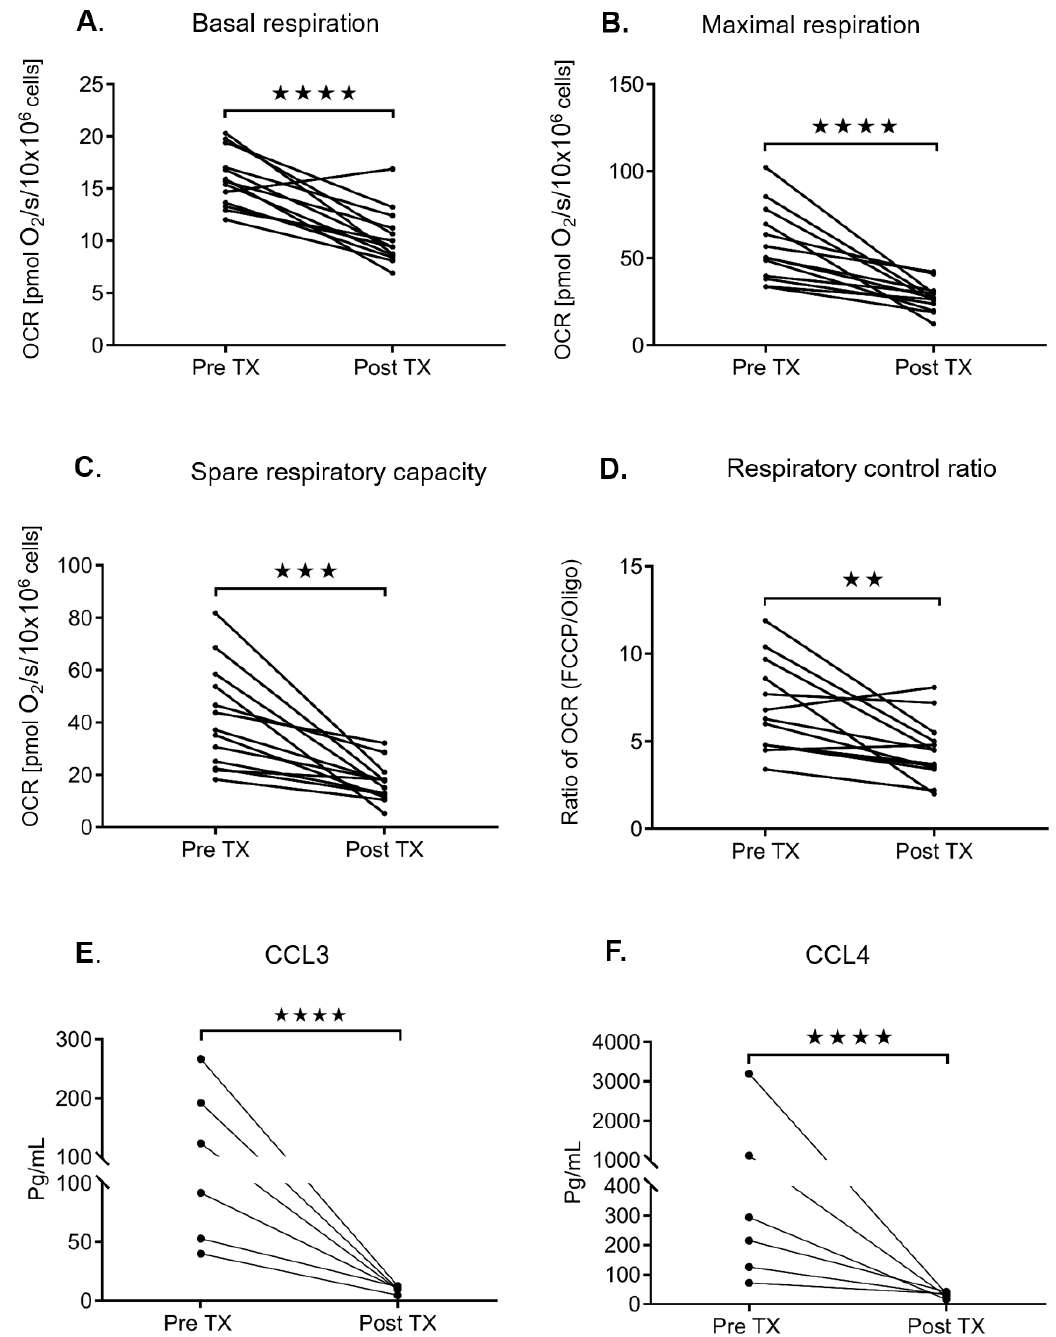
Figure 5. Comparison of mitochondrial bioenergetic profiles in pre- and post-ibrutinib treated CLL patients. The effect of ibrutinib treatment on basal respiration ( A ), maximal respiration ( B ), the spare respiratory capacity ( C ), the respiratory control ratio ( D ), CCL3 levels ( E ), and CCL4 levels ( F ) in pre- and post- treated ibrutinib CLL samples from the same patients is displayed. N = 13 for A–D and N = 6 for E–F. Values are the mean ± S.D., where ** p < 0.01, *** p < 0.0005, and **** p < 0.0001 (unpaired two-tailed Student’s t- test).